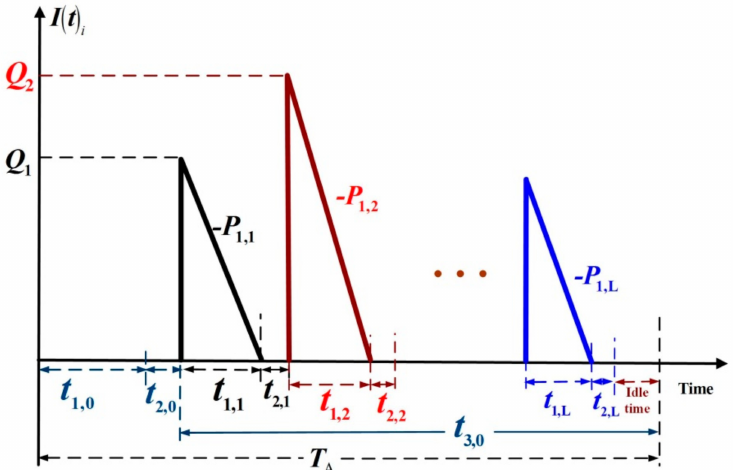
Figure 2. A clarified common part’s inventory status during the production process of end product